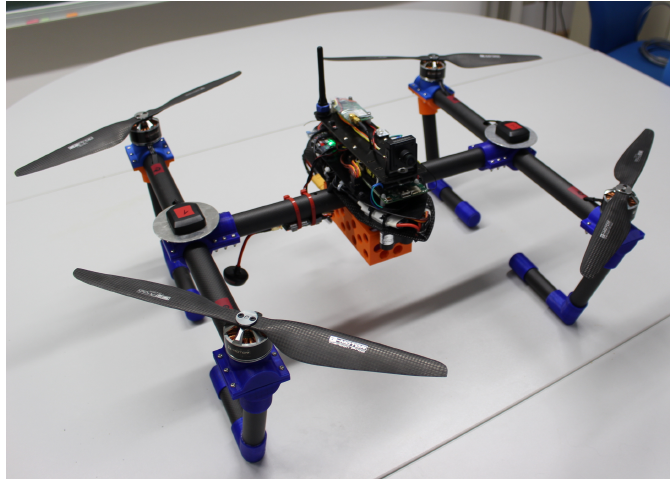
Figure 3. The ROBEX